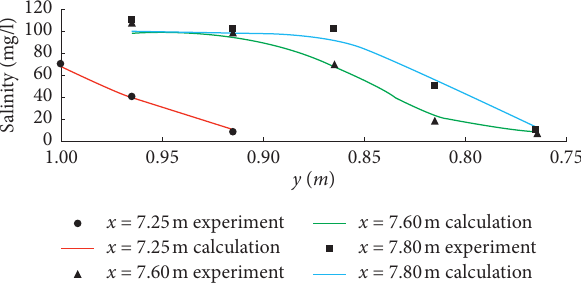
Figure 2: Comparison of the salinity between the model and the